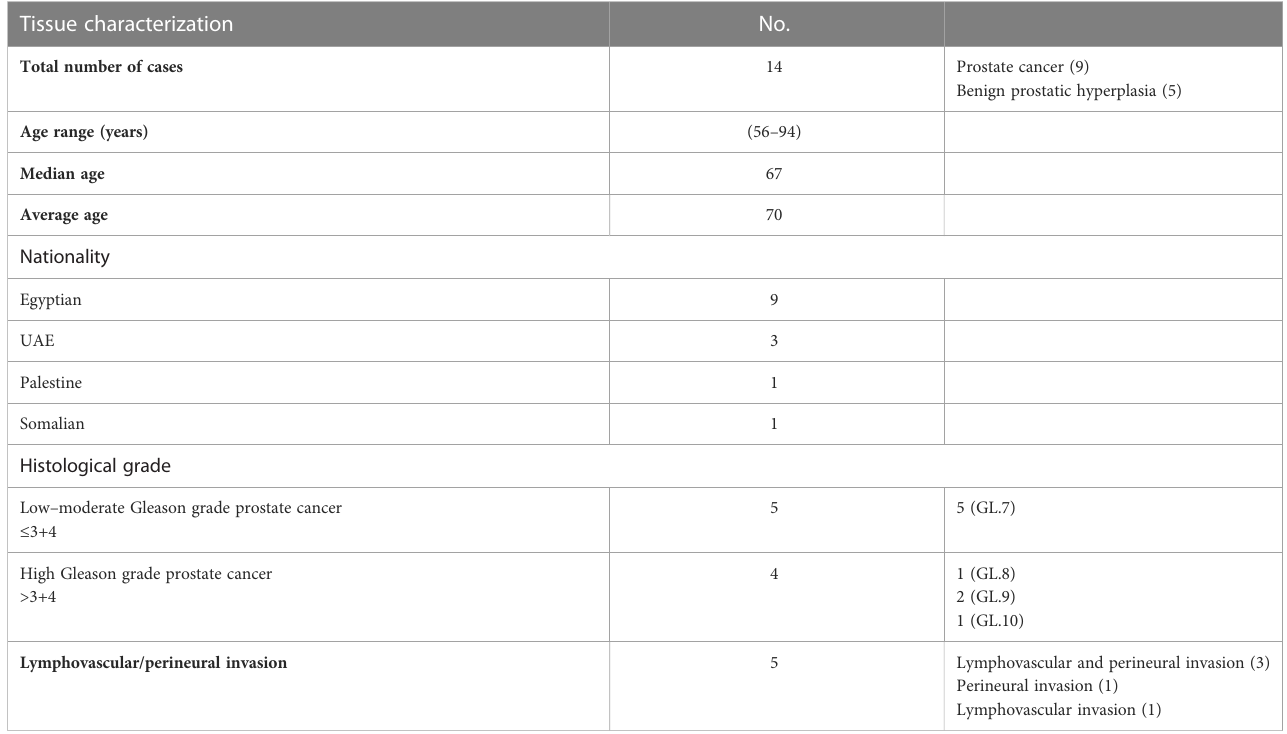
TABLE 1 The clinicopathological parameters of our patient cohort. Tissue